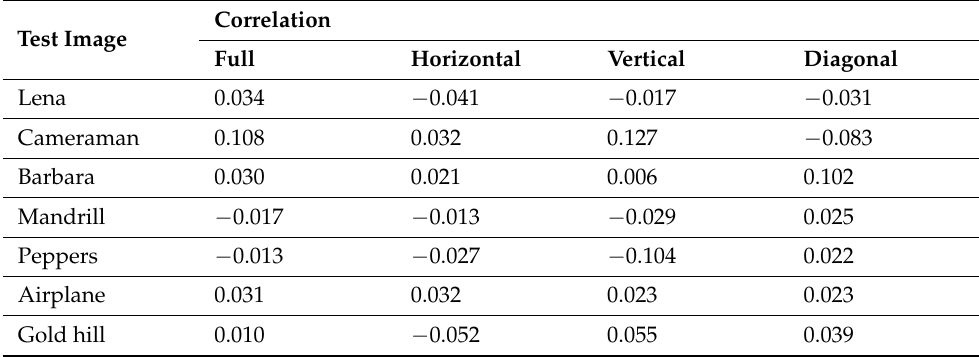
Table 3. Correlation between Original Test Images and their Scrambled Versions.